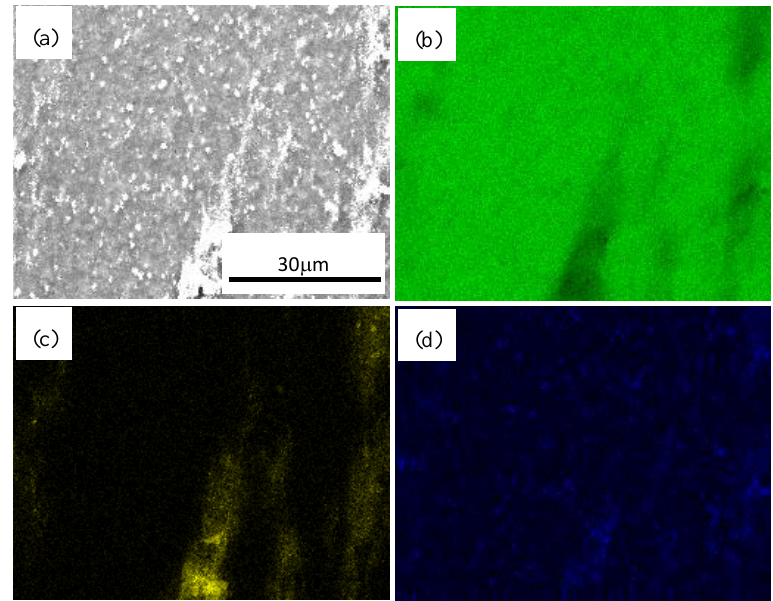
Figure 9. SEM micrographs at high magnification of nano-SiCp/AZ91 composite 6 passes at 400 °C, 3 passes at 350 °C and 3 passes at 300 °C: ( a ) ditribution of SiC nanoparticles, EDS of ( b ) Mg K; ( c ) Si K; ( d ) Al K.